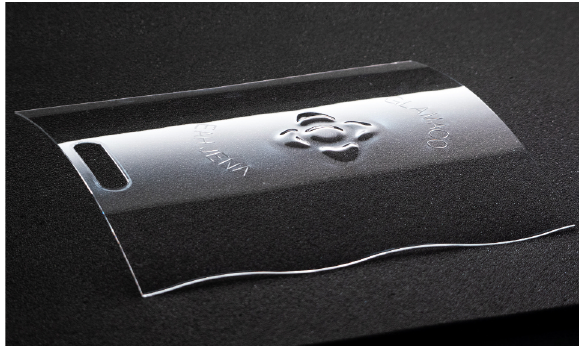
Fig. 3. Generated borosilicate glass component (0.7 mm thick